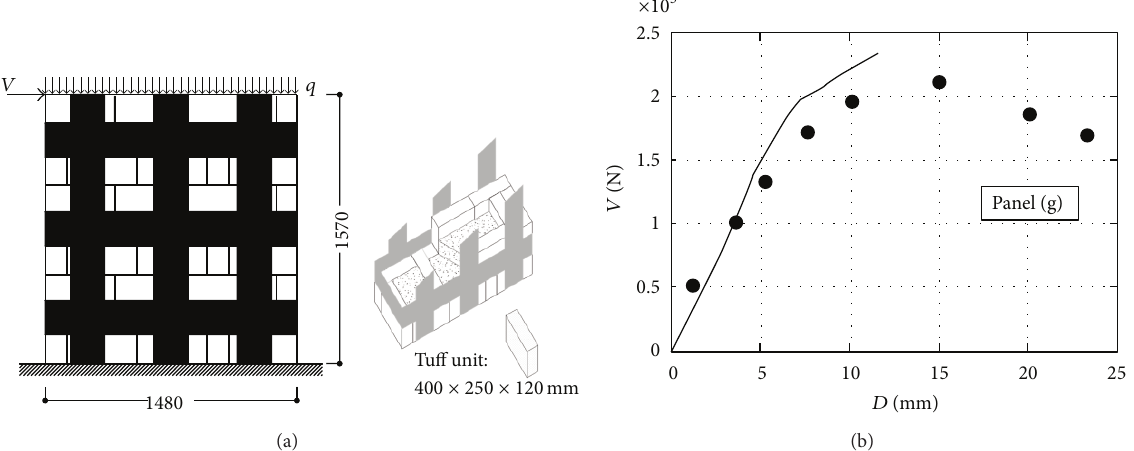
Figure 11: (a) Dimensions and strips arrangement of the considered FRP-strengthened panel [27]. (b) Comparison between numerical and experimental capacity curves of the FRP-strengthened